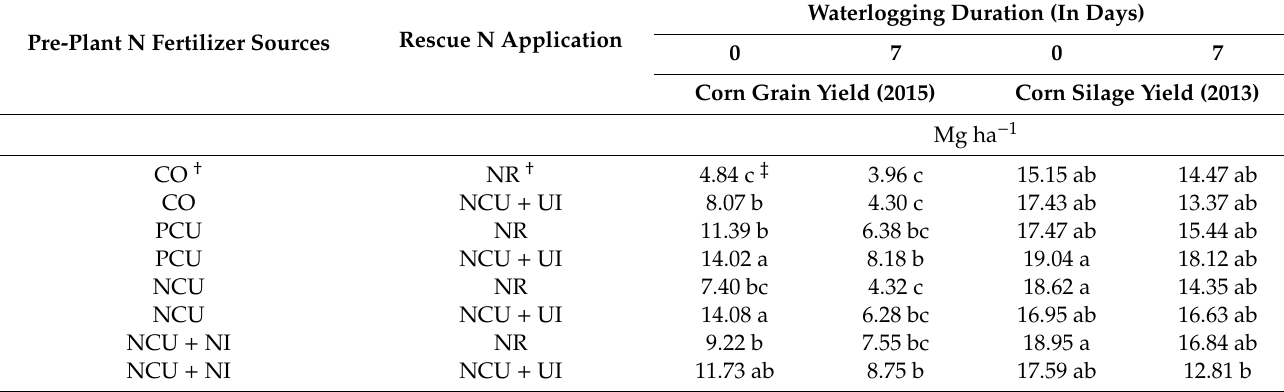
Table 4. Waterlogging duration, pre-plant N fertilizer sources and rescue N application e ff ects on corn grain yield in 2015 and silage yield in